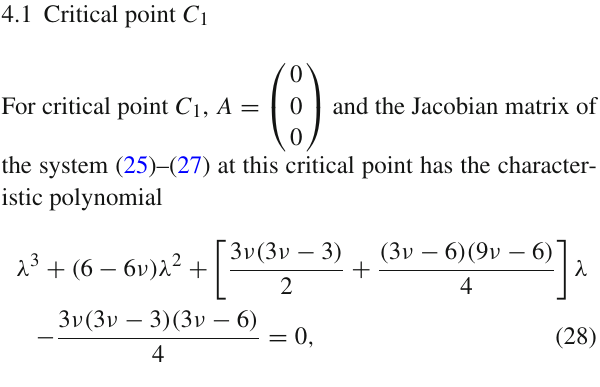
Table 4 Summary for the critical point C